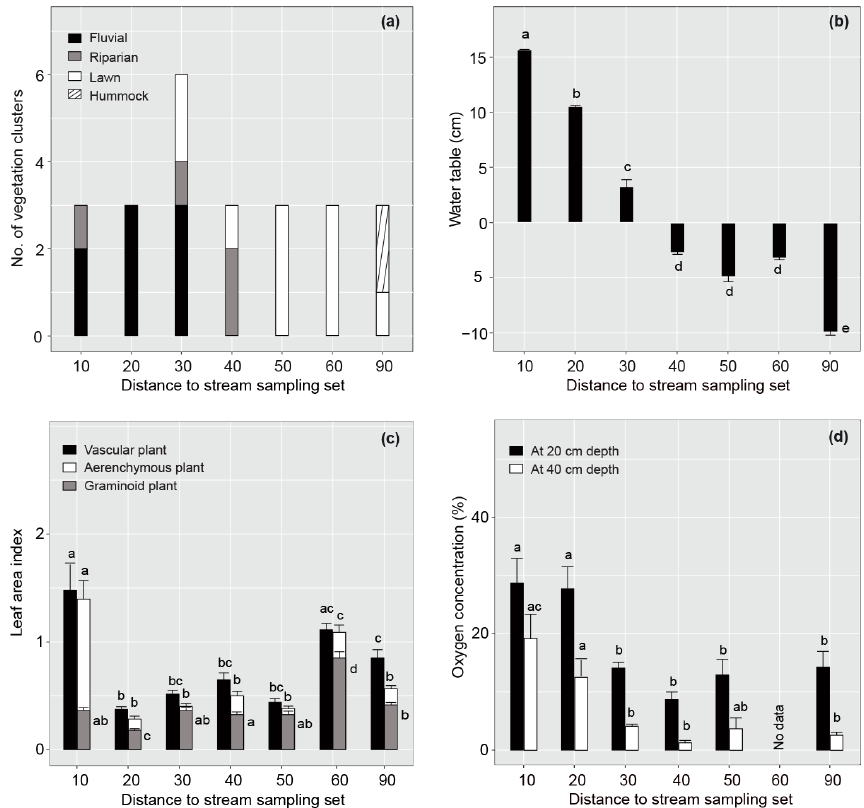
Figure 2. Spatial variation in vegetation and environmental factors in relation to the distance of the sample plot set from the stream in summer 2019. (a) Occurrence of different plant community types, (b) mean ( ± standard error) water table relative to peat surface (cm), (c) vascular, aerenchymous and graminoid plant leaf area index, and (d) dissolved oxygen concentration at 20 and 40cm below the peat surface for each sample plot set. Note that dissolved oxygen concentration was not measured in set 60. Different letters above the bars indicate significant differences ( p < 0 . 05) between the sample plot sets calculated using Tukey’s honest significant difference method. For species composition in the different plant community types, see Fig. 3 and Table